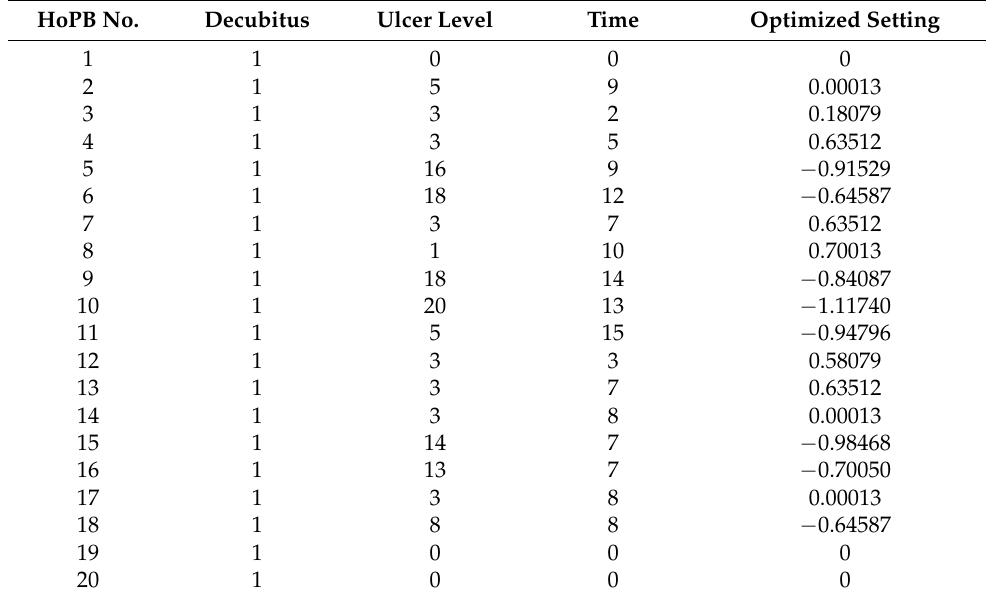
Table 5. Performance results of the ConvLSTM and Fuzzy Inference. HoPB